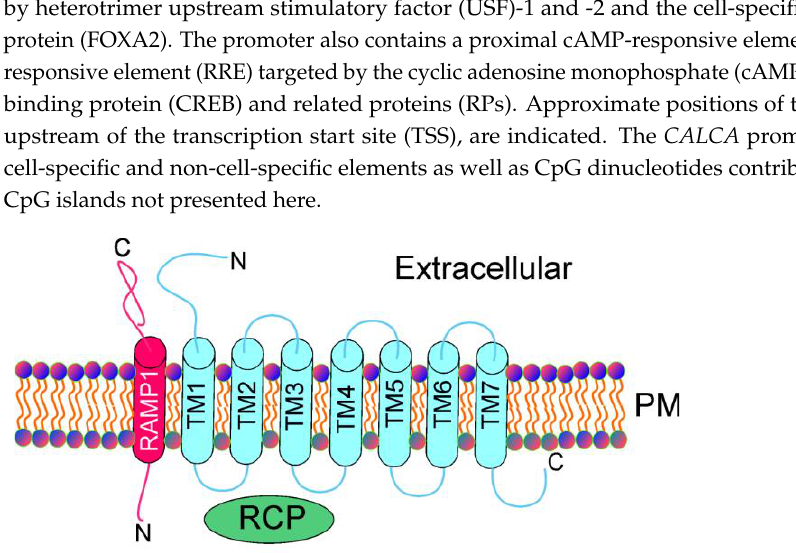
Figure 1. The main regulatory element in the promoter of calcitonin gene-related polypeptide alpha ( CALCA ) is an 18-bp enhancer, which is a part of a distal cell-specific complex helix – loop – helix (HLH) enhancer. The HLH motif of the 18-bp enhancer overlaps with a forkhead (FOX) motif and is targeted by heterotrimer upstream stimulatory factor (USF)-1 and -2 and the cell-specific forkhead box A2 protein (FOXA2). The promoter also contains a proximal cAMP-responsive element (CRE) and a Ras responsive element (RRE) targeted by the cyclic adenosine monophosphate (cAMP) re- sponse element-binding protein (CREB) and related proteins (RPs). Approximate positions of these two elements, upstream of the transcription start site (TSS), are indicated. The CALCA promoter contains both cell-specific and non-cell-specific elements as well as CpG dinucleotides contributing to functional CpG islands not presented here.